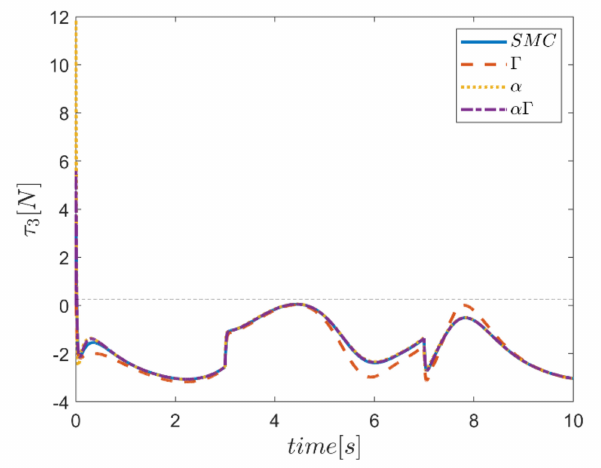
Figure 52. Comparison of the input force in the third actuator.